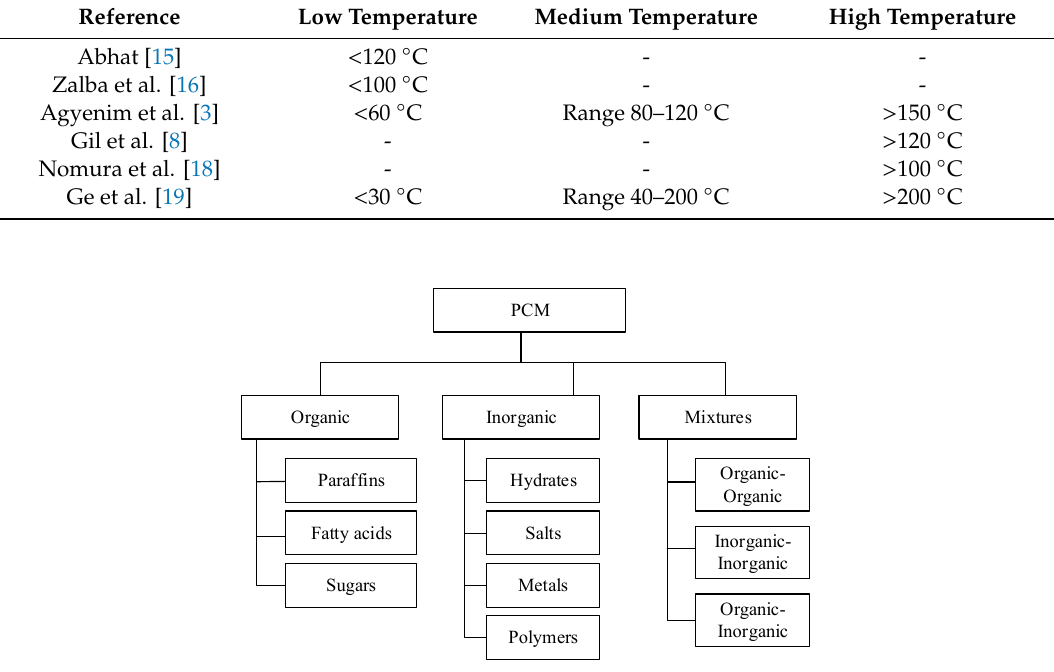
Table 1. Phase change materials classification, according to phase change temperature.